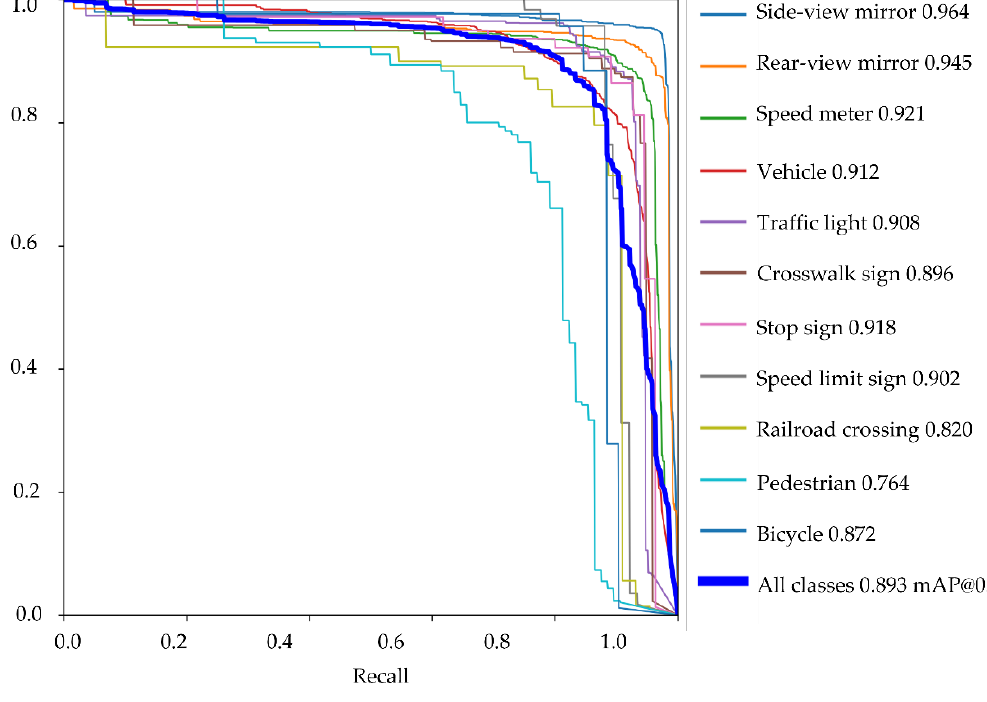
Figure 5. Example of object detection. 4.4. Dual Task We used the dual task to verify the driver ’ s reaction under cognitive stress. The meas- urement environment for the dual task is shown in Figure 6. The experiment was con- ducted indoors. The subject wore an IMU sensor on his/her left foot.